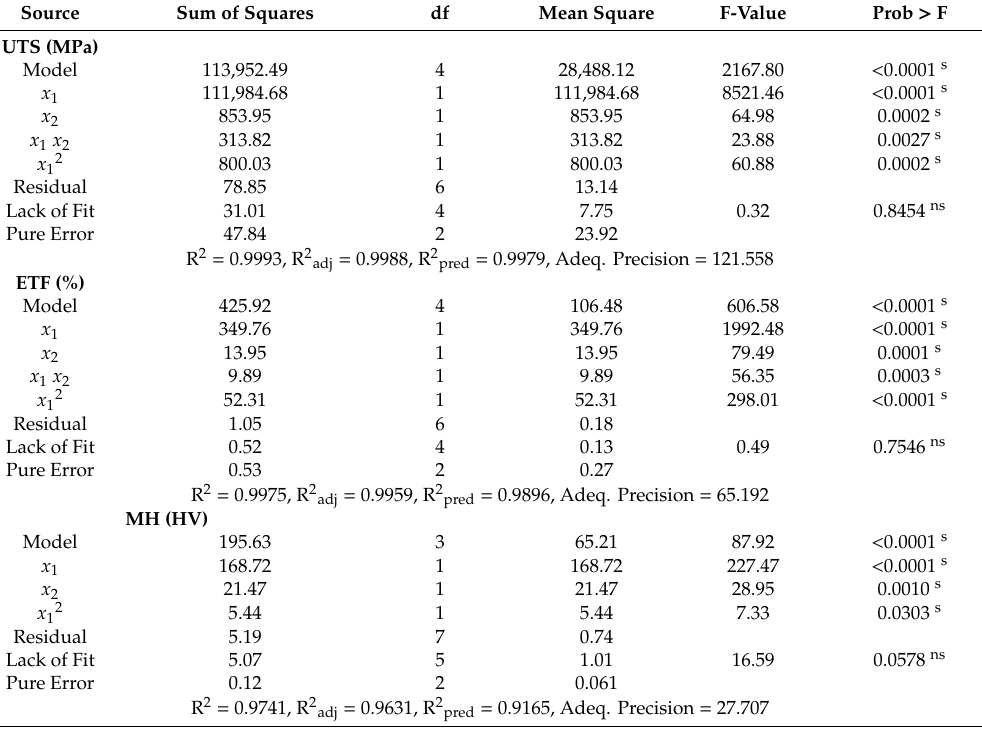
Table 5. ANOVA table (partial sum of squares) for the reduced quadratic model.